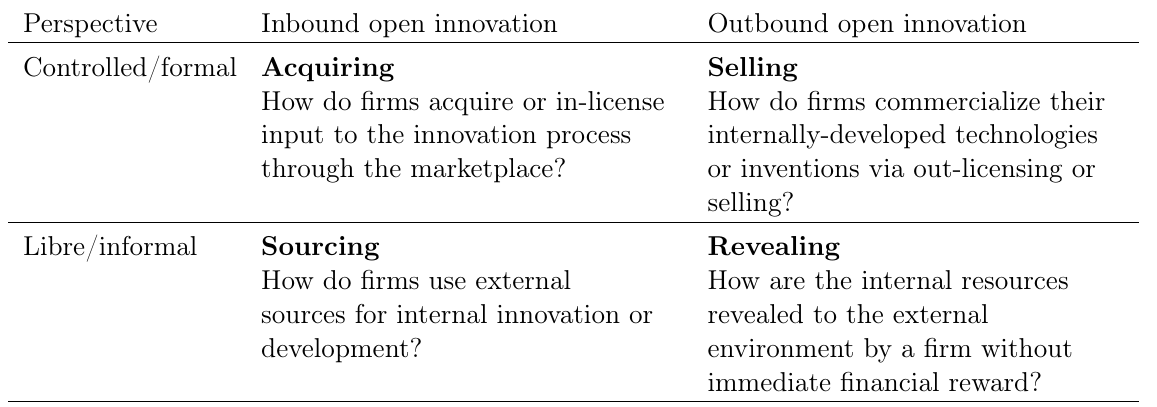
Selling How do firms commercialize their internally-developed technologies or inventions via out-licensing or selling? Revealing How are the internal resources revealed to the external environment by a firm without immediate financial